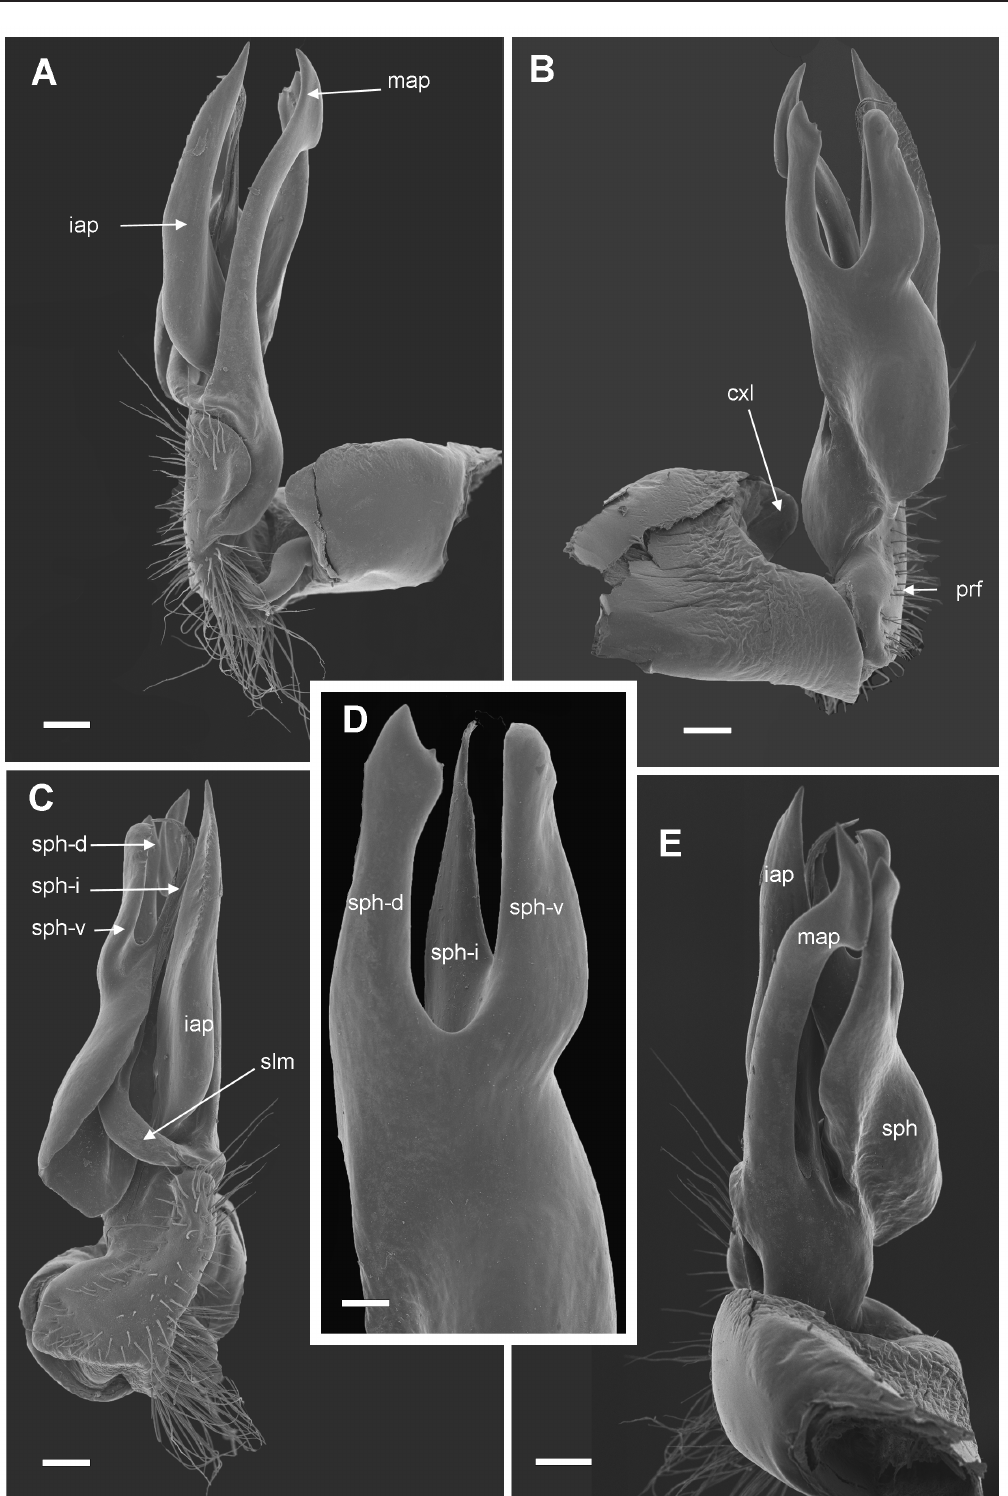
Fig. 11. Eviulisoma aequilobatum sp. nov., holotype, right gonopod. A . Mesal view. B . Lateral view. C . Ventral view. D . Tip of solenophore, sublateral view. E . Dorsal view. Abbreviations: cxl = coxal lobe; iap = intermediate acropodital process; map = mesal acropodital process; prf = prefemoral part; slm = solenomere; sph-d , sph-i , sph-v = dorsal, intermediate and ventral lobes of solenophore. Scale bars: A–C, E = 0.1 mm; D = 0.05